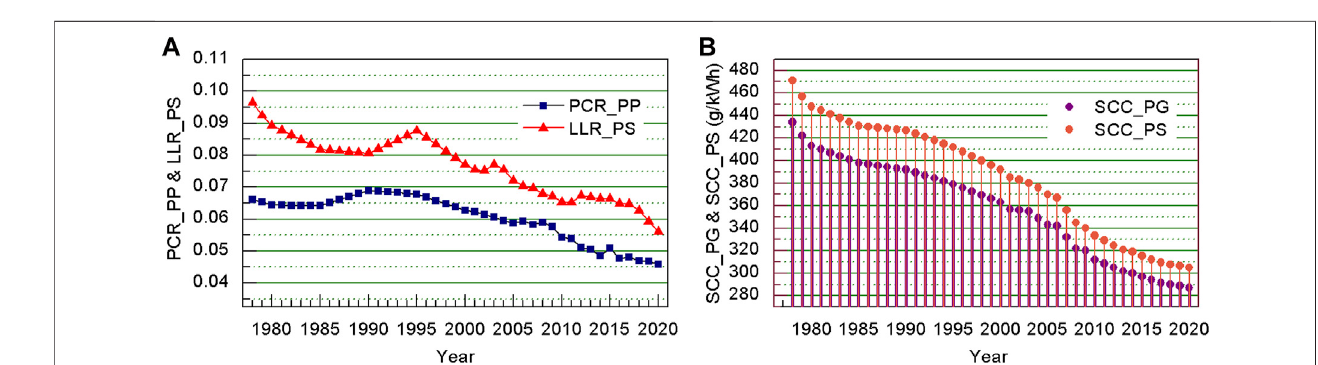
FIGURE5| Powergenerationef fi ciencyandcoalconsumptionofChina ’ spowerplants.Source:ThedatawereobtainedfromCHINAELECTRICITYSTATISTICAL YEAR BOOK 2021.